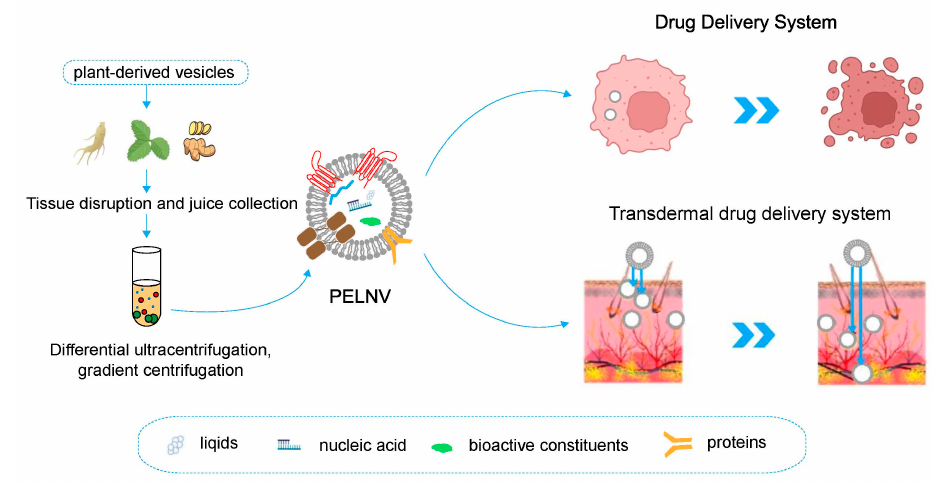
Figure 1. Overview of biological functions of PELNVs and their therapeutic applications.